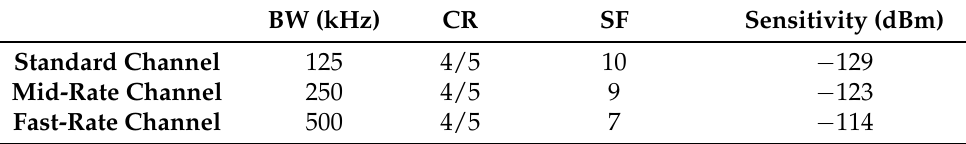
Table 2. Radio parameters characterizing the different LoRa channels used in this work.